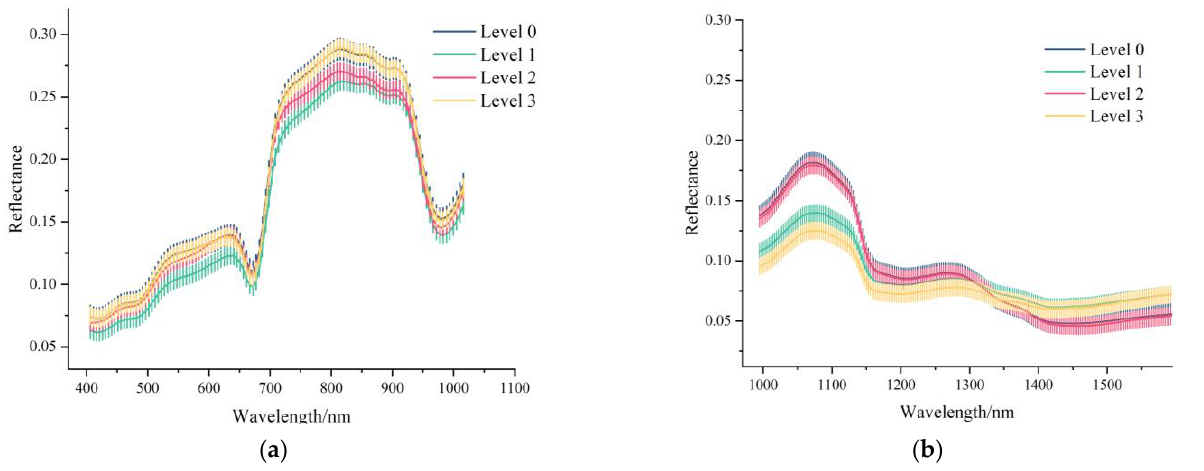
Figure 5. ( a ) Vis-NIR average (405 – 1016 nm) spectra with standard deviation each wavelength of different levels of pesticide residues in grape, using Vis-NIR spectrometer. ( b ) NIR average spectra (994 – 1641 nm) with standard deviation each wavelength of different levels of pesticide residues in grapes, using NIR spectrometer.